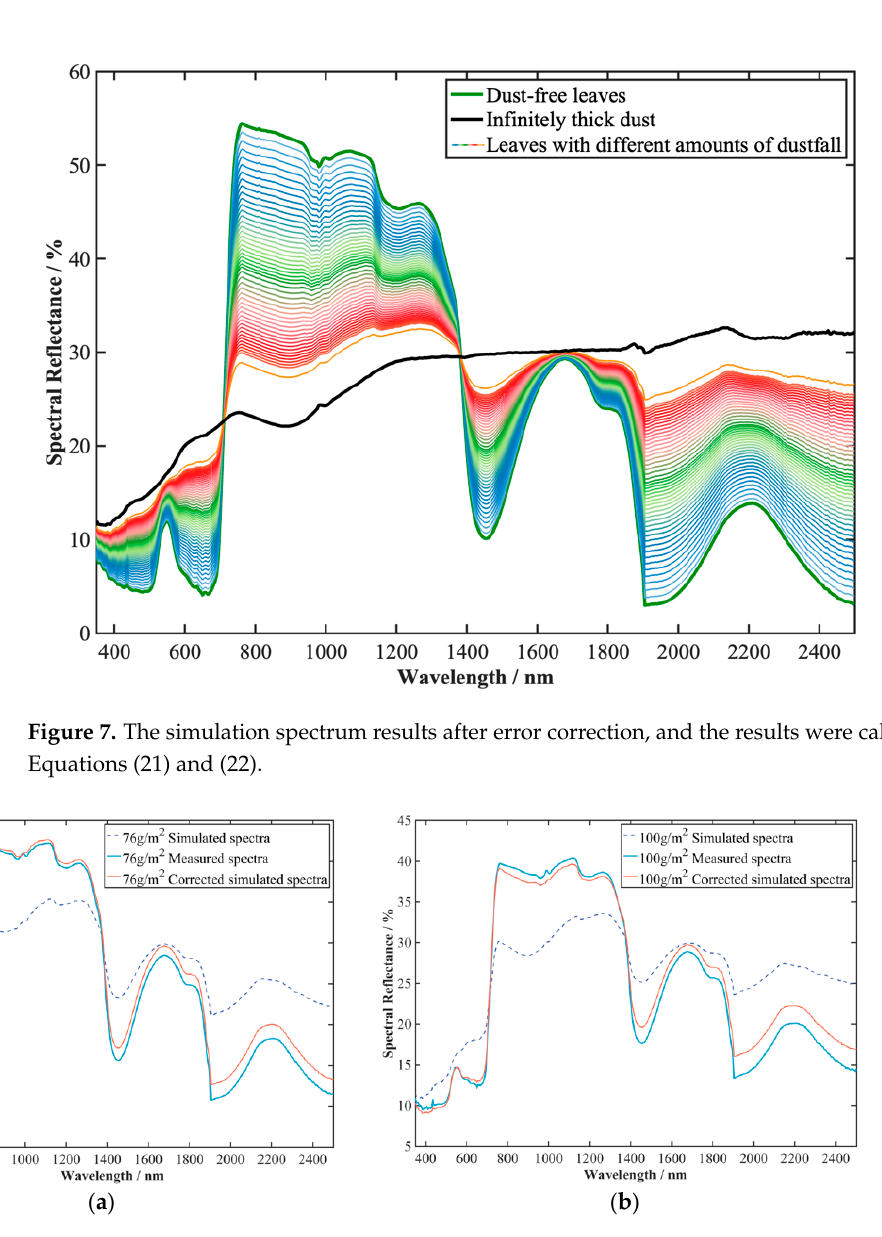
Figure 8. The corrected simulated spectral reflectance was compared with the measured spectrum: ( a ) is the spectrum at a dustfall amount of 76 g/m 2 ; ( b ) is the spectrum at a dustfall amount of 100 g/m 2 .